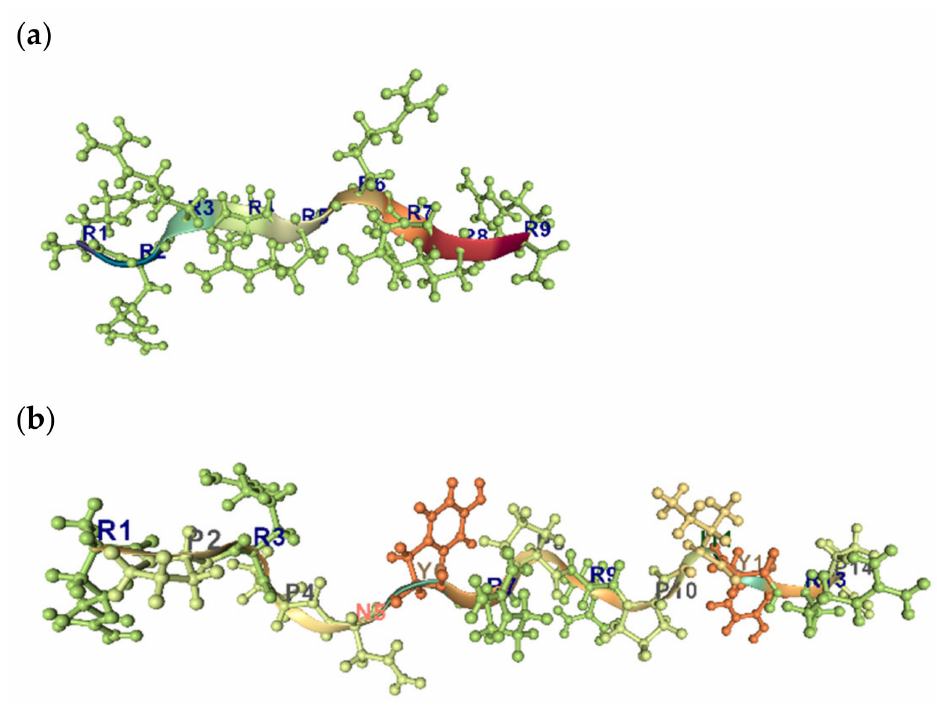
Figure 8. Representative structures constructed on the basis of MD trajectories simulated for the AMPs: ( a ) R9 (DBAASP [17] ID = 9015), and ( b ) Astacidin (DBAASP [17] ID = 2145). Side chain heavy atoms are represented in ball-and-stick, and the backbone is represented in cartoon color-coded by residue